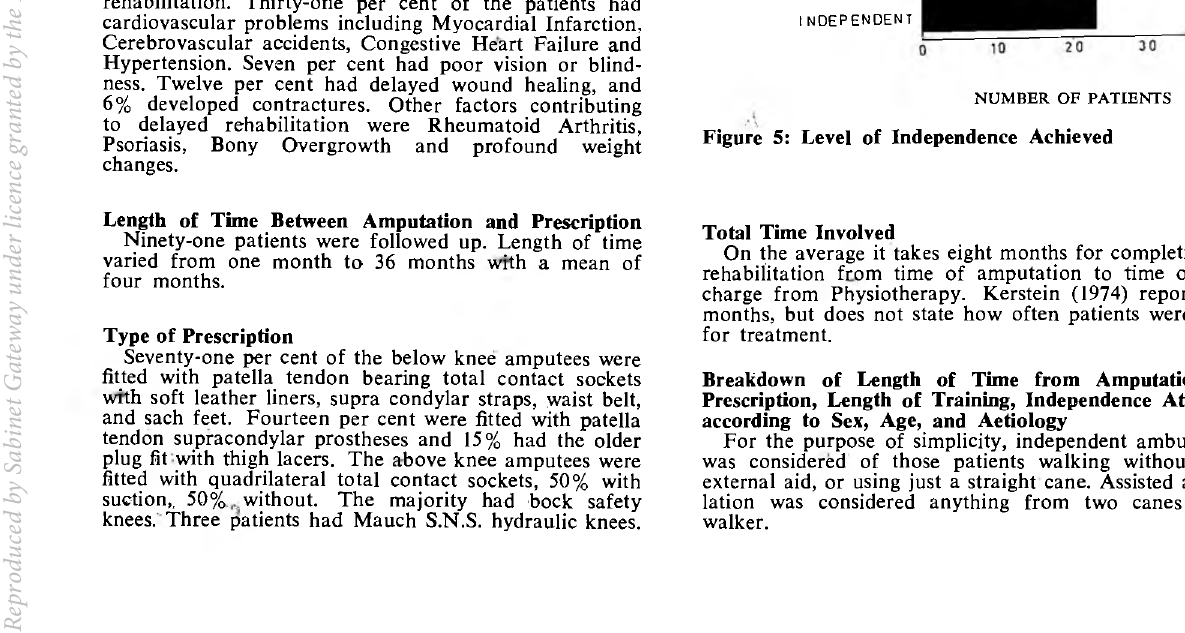
Figure 5: Level of Independence